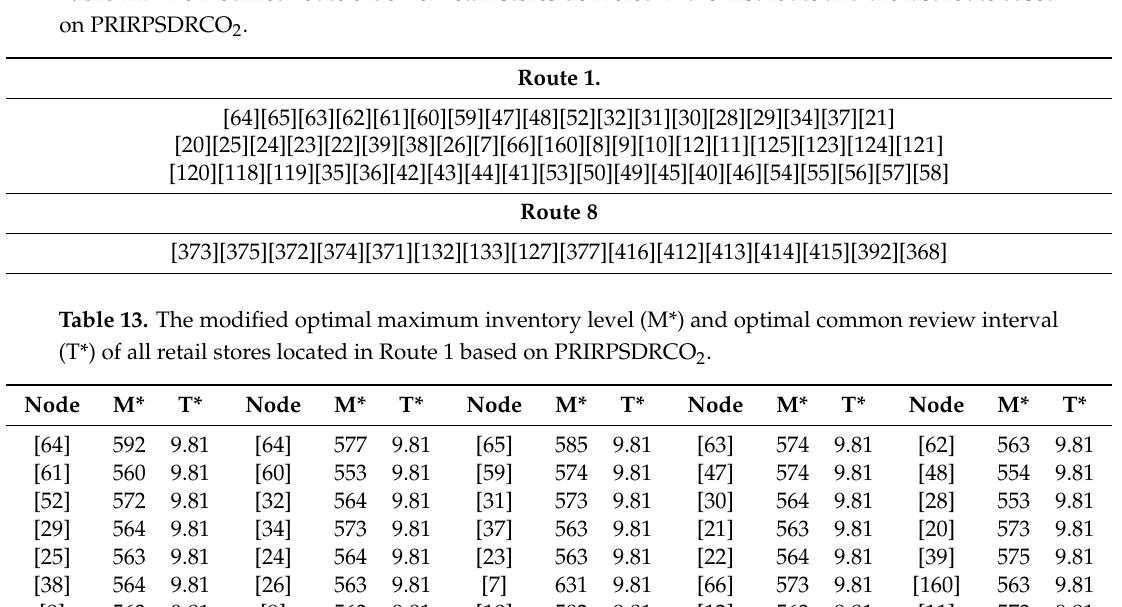
Table 12. The modified route order for retail stores delivered in the first route and the last route based on PRIRPSDRCO 2 .